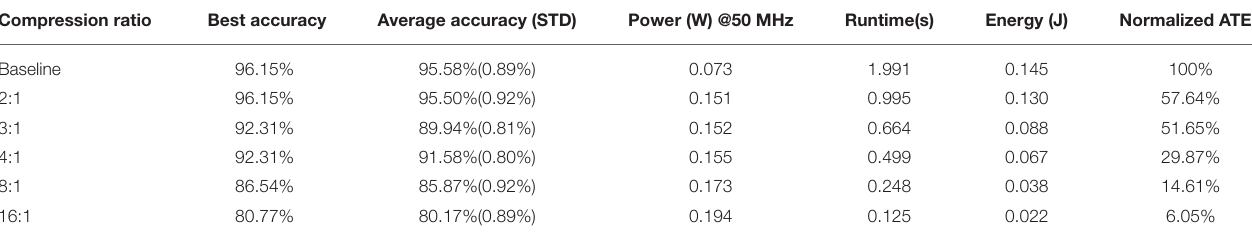
TABLE 5 | Performances of the reconfigurable PTC-SNN hardware accelerator on the TI46 Speech